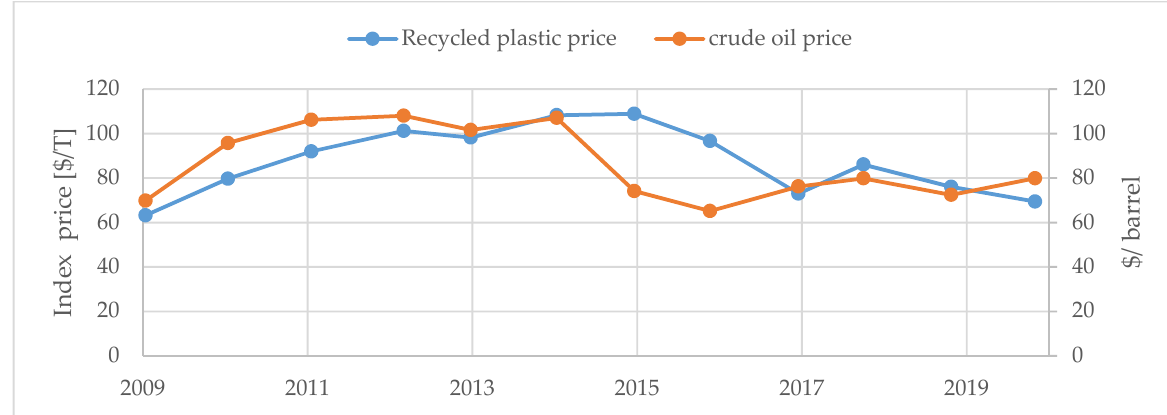
Figure 2. Recycled price index and crude oil price. Recycled plastic price tends to be positively correlated with the crude oil price. COVID-19 lockdowns hit oil and gas inputs, leading to the collapse of global demand for fossil fuels. As a result, oil prices dropped, making the manufacture of virgin plastics from petroleum less expensive than recycling. Hence, prices of recycled plastics are likely to plummet. (Data source: St Louis Fed Research. Available online: https://fred.stlouisfed.org/series/DCOILWTICO) (accessed on 12 December 2020). Table 1. Literature review on oil and primary and secondary plastic products prices